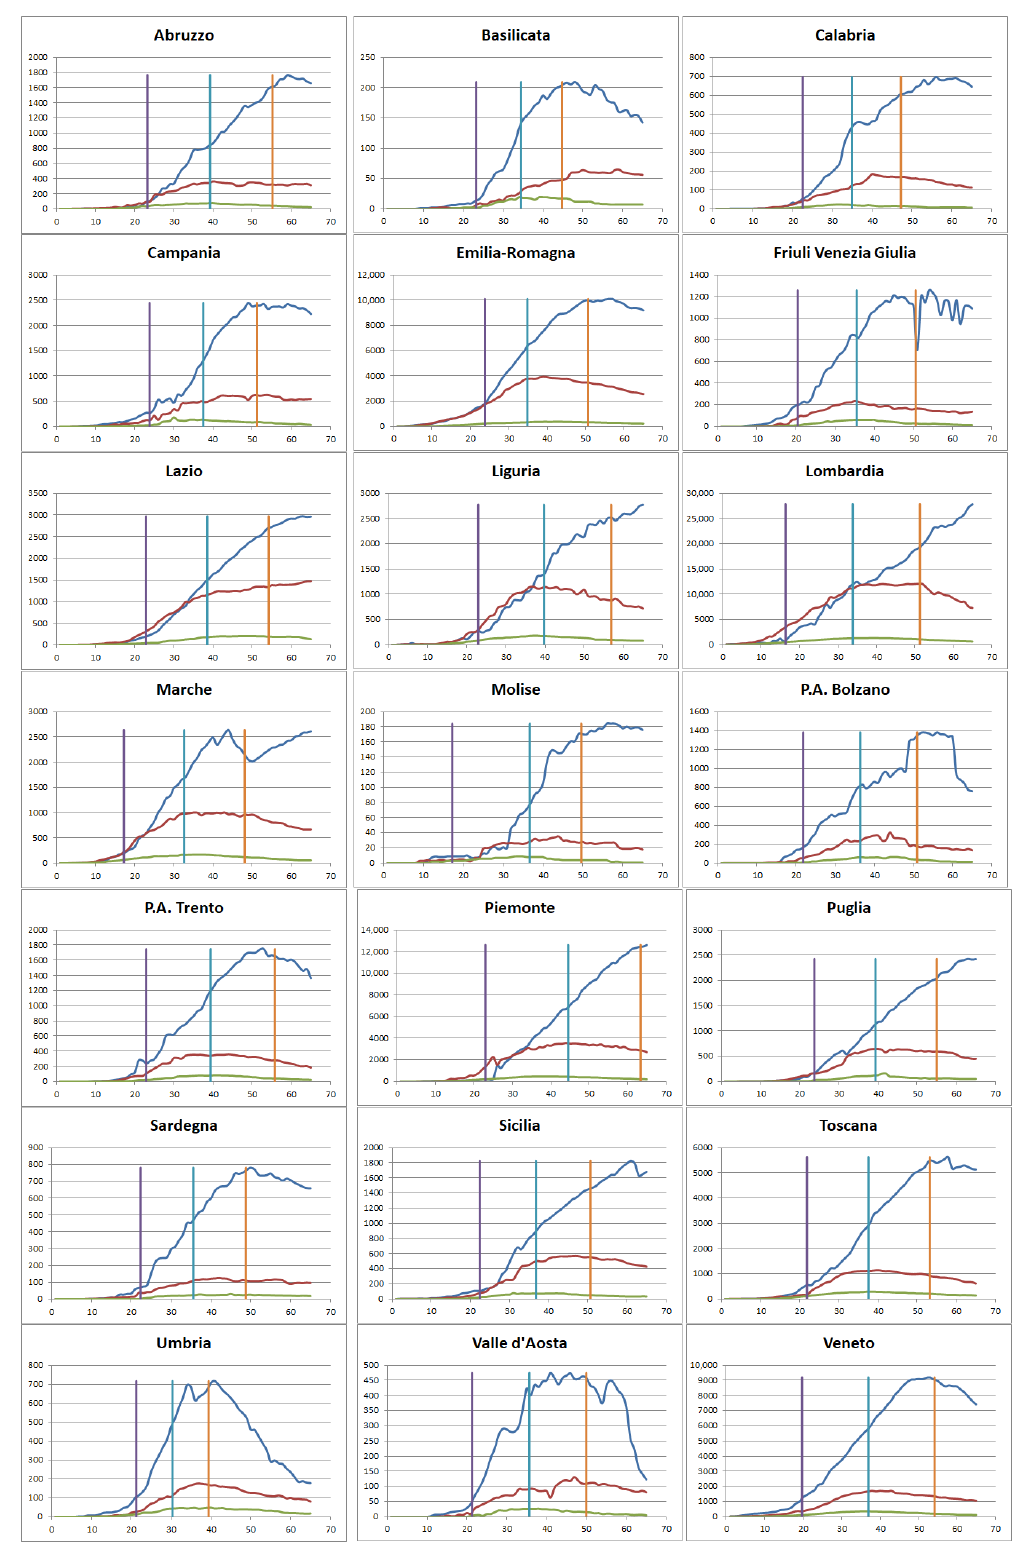
Figure 3. Cumulative number of cases over time hospitalized (red line), confined at home (blue line) and treated in the ICU (green line). Vertical lines identify the transition between the different epidemic phases: the violet line specifies the transition between the initiation and the acceleration phases, the azure one between the acceleration and the deceleration phases and the orange one between the deceleration and the preparation